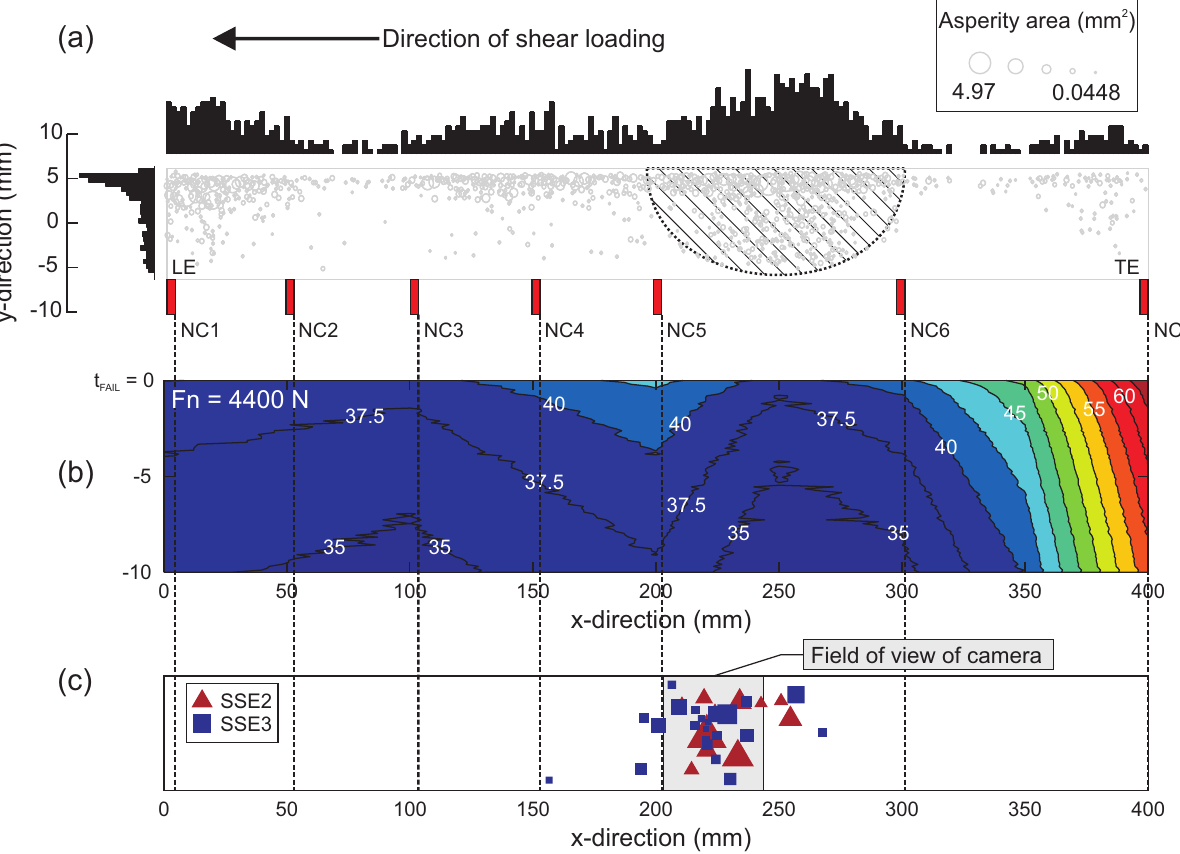
Figure 11. ( a ) Asperity locations are shown as circular patches on the interface with areas equivalent to that measured using the pressure-sensitive film; ( b ) slow slip measured along the fault using the slip non-contact sensors (NC1–NC7) over the last 10 s before rapid slip; ( c ) locations of foreshocks for SS2 (red triangles) and SS3 (blue squares). The sizes of the symbols are proportional to the magnitude of shaking from the